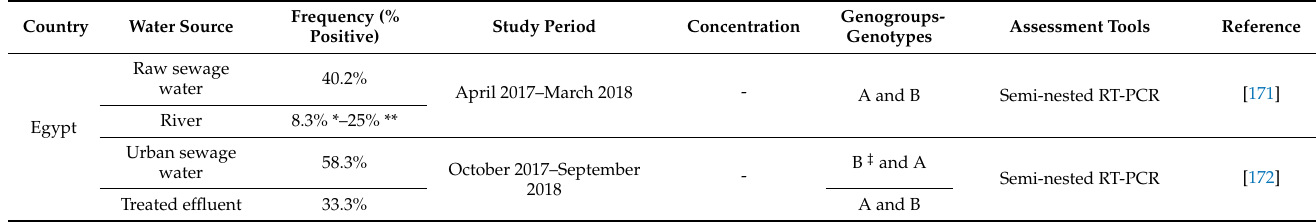
Table 5. Prevalence of waterborne astroviruses, predominant genogroups, and assessment